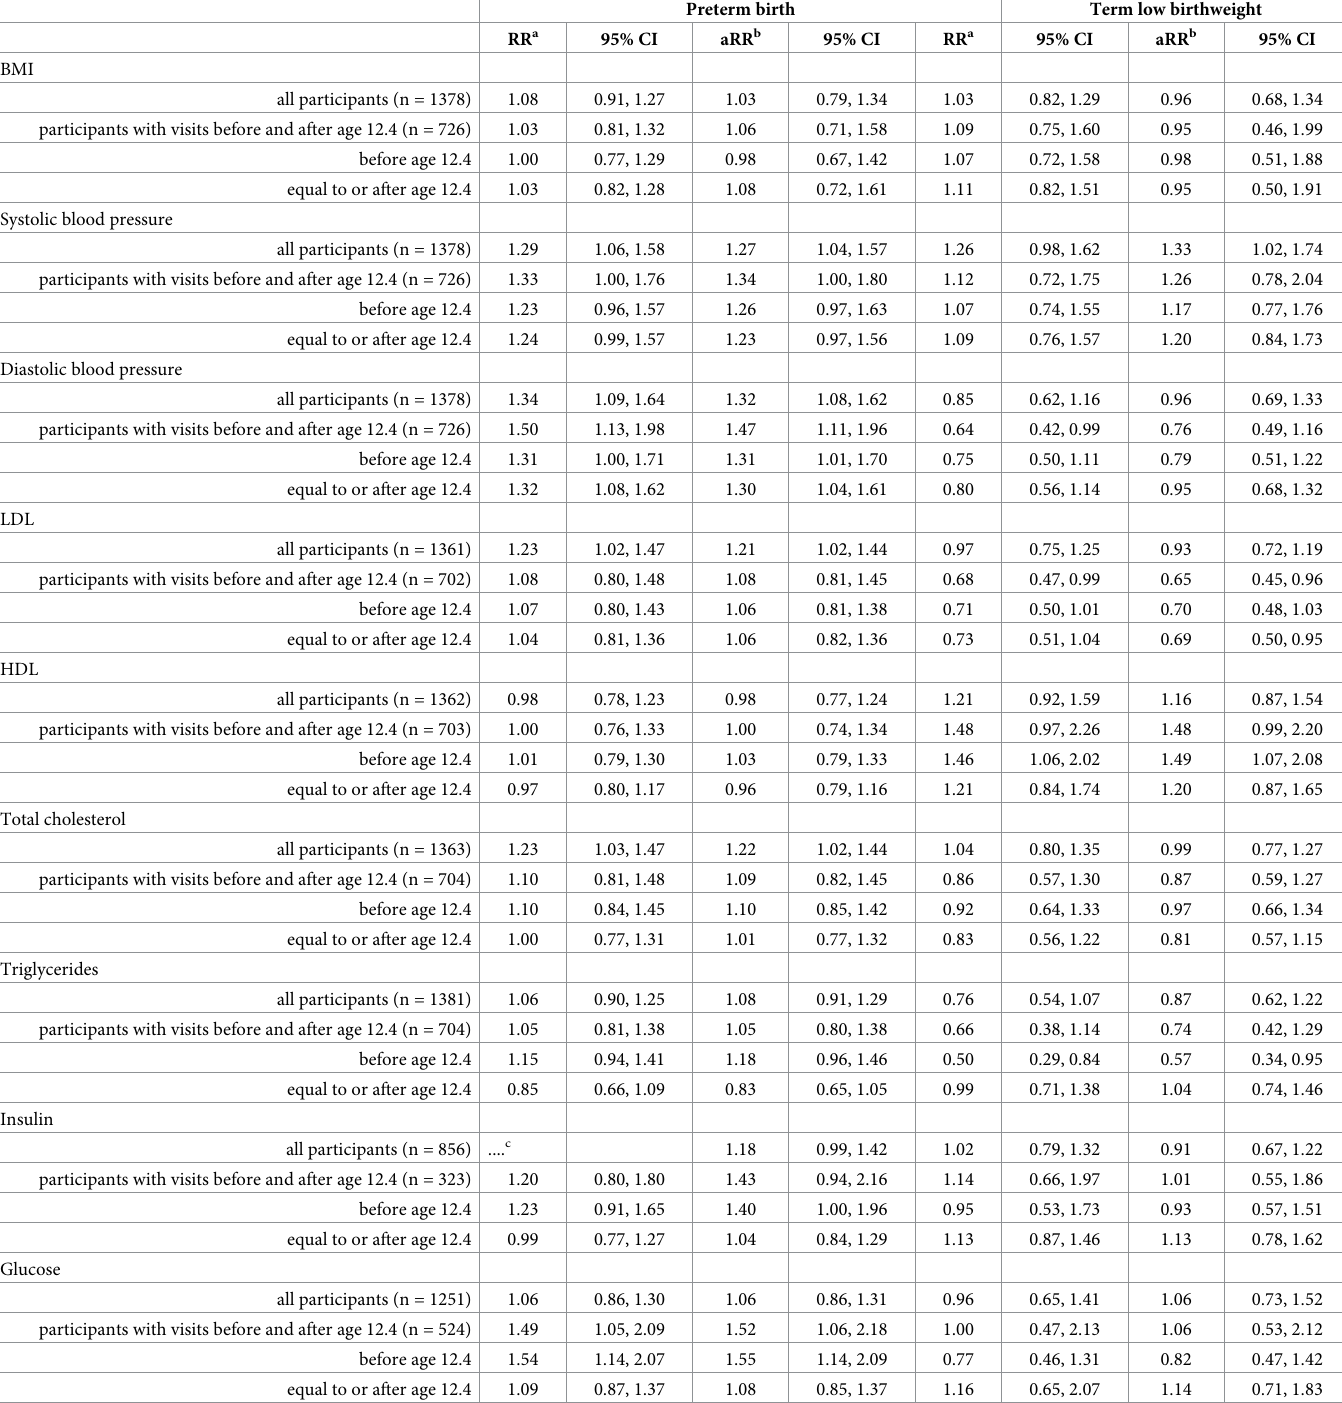
Table 2. Associations between adverse birth outcomes and cardiovascular risk factors among participants with early and late childhood measures, stratified by aver- age age at puberty, the Bogalusa babies study. Preterm birth Term low birthweight RR